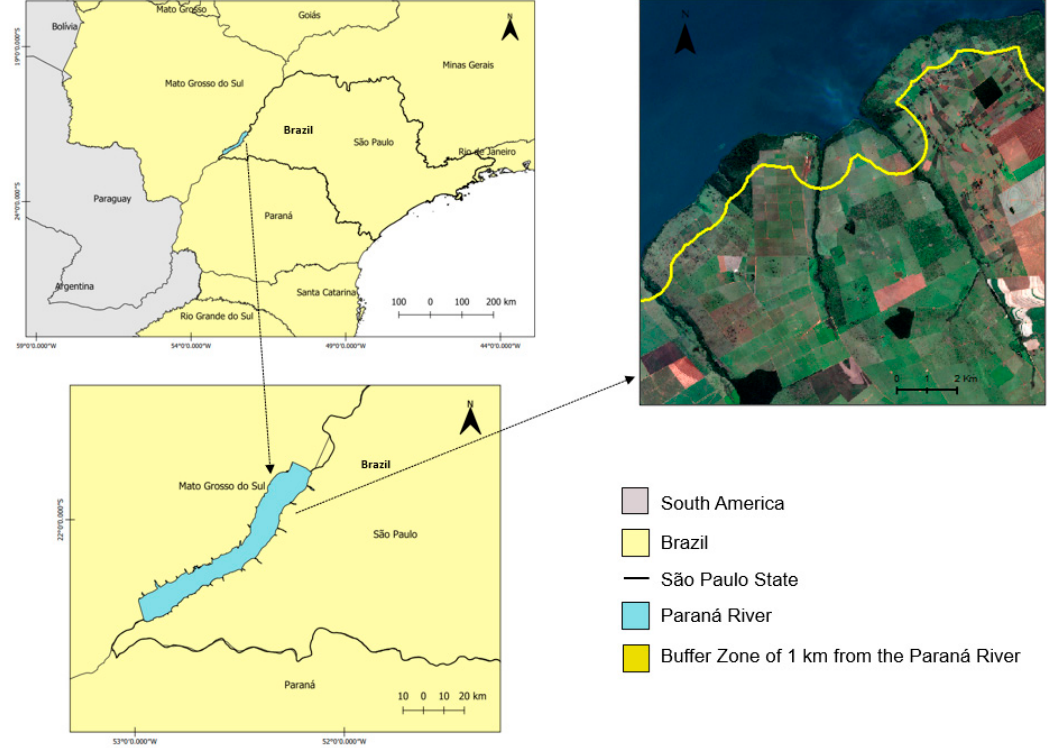
Figure 2. Study area and an example of 1 km of the riparian zone.